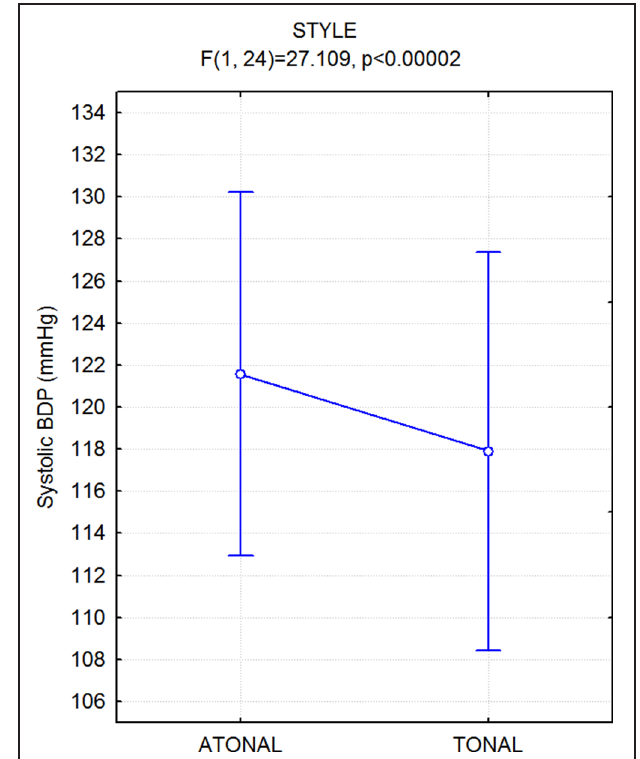
FIGURE 7 | Mean values of systolic blood pressure (sysBDP), along with standard errors, recorded while participants listened to atonal vs. tonal music